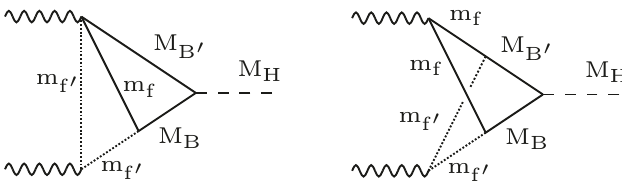
Figure 3 . Collinear structures that do not appear in the alignment limit are shown. Massless particles are marked as wavy or dotted lines, while solid lines denote massive